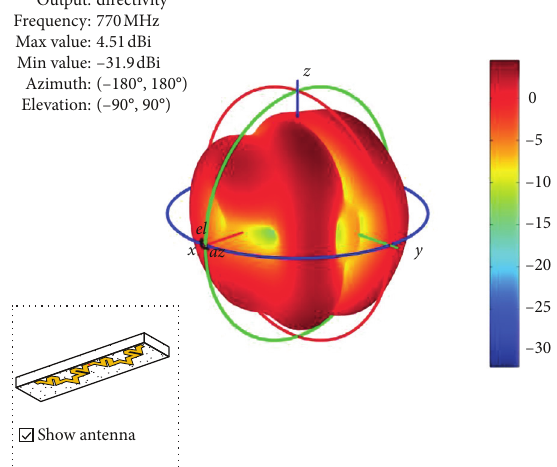
Figure 13: One-iteration fractal Koch antenna radiation pattern and phase at